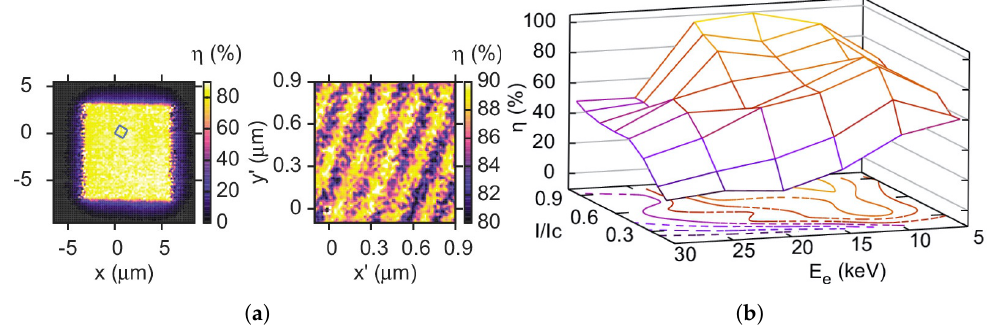
Figure 6. ( a ) Map of detection efficiency across the SNSPD pixel (left) under bombardment of 20 keV electrons, with a zoom in on a small part of the meander showing the non-zero detection probability outside of the superconducting meander. ( b ) A parameter sweep map that show the electron detection efficiency as a function of the reduced device bias current I / I C and electron kinetic energy E e . Figures reproduced from Rosticher, et al., Appl. Phys. Lett. 97 , 183106 (2010)